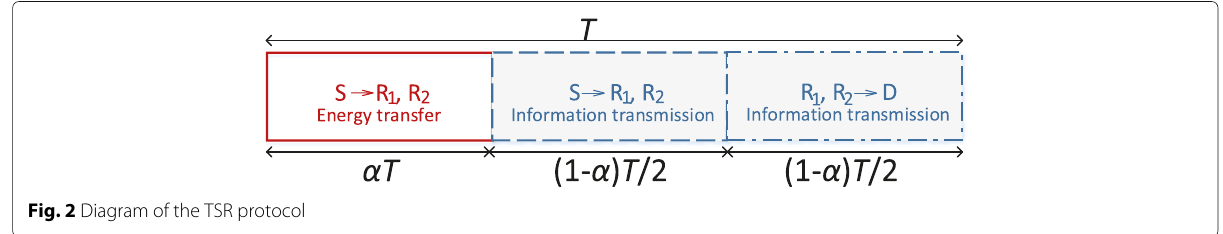
Fig. 2 Diagram of the TSR